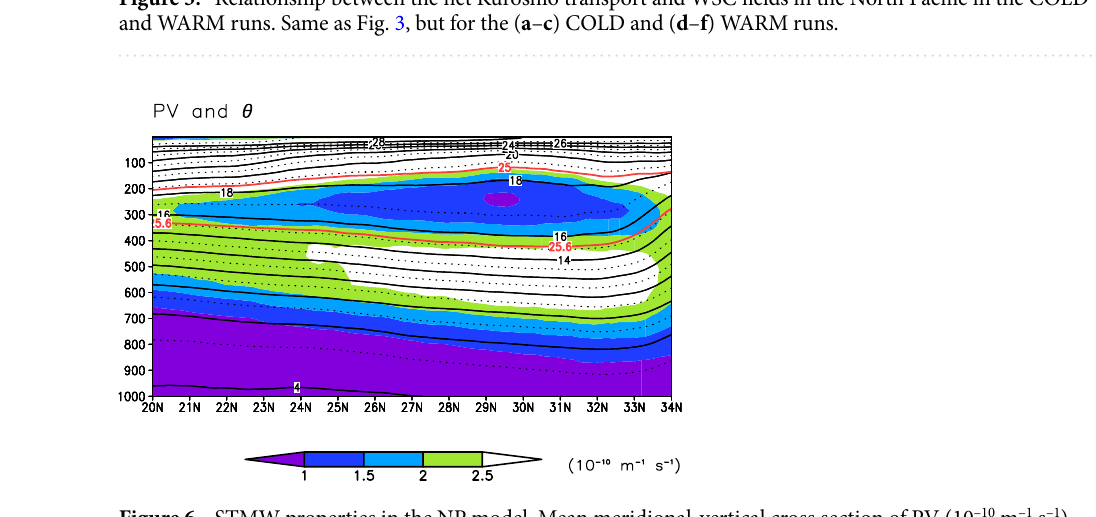
Figure 6. STMW properties in the NP model. Mean meridional-vertical cross section of PV (10 –10 m –1 s –1 ) (shading) and θ (°C) (contours) in August for 1978–2013 averaged over 140–150°E in the CTRL run. Red lines indicate isopycnal surfaces of σ θ = 25.0 and 25.6 kg m –3